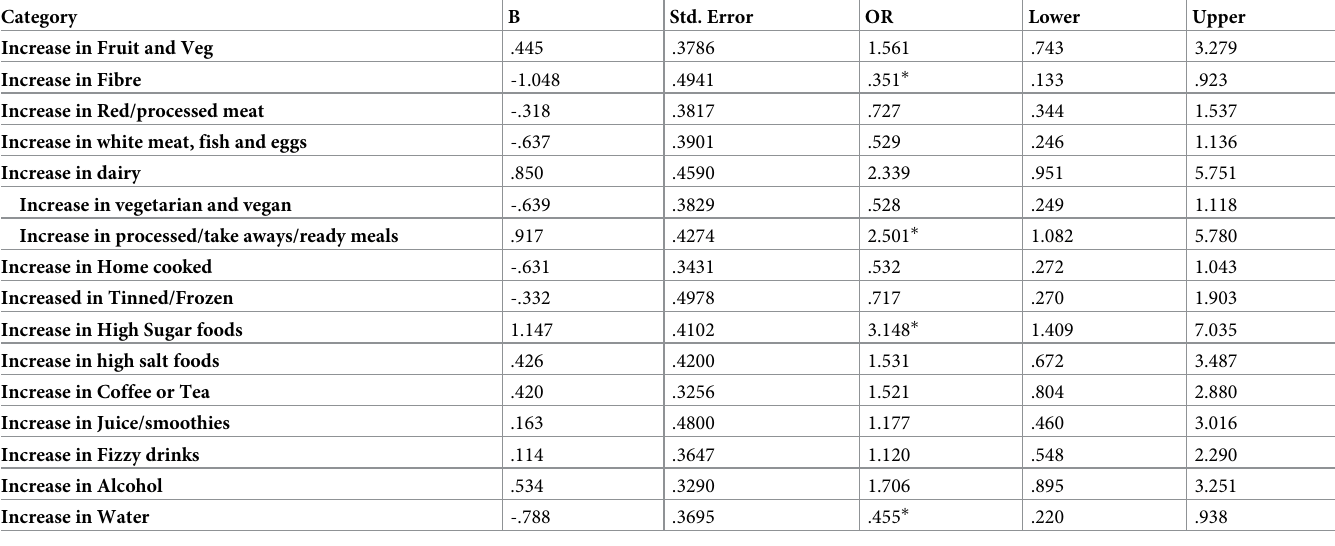
Table 5. Food and drink coefficients of the predictive model for weight